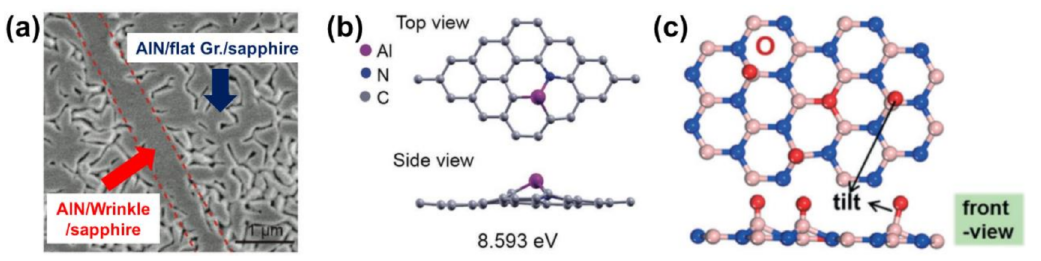
Figure 21. ( a ) SEM image of AlN grown on graphene wrinkle arrays. Due to the increased nucleation sites caused by graphene wrinkles, AlN grown on the wrinkles (red region) demonstrates faster lateral coalescence. Reprinted from [97] with copyright permission. ( b ) Schematic diagrams of atom connective structure of graphene after N 2 plasma treatment. The purple, blue, and gray solid balls represent Al, N, and C atoms, respectively. Reprinted from [96] with copyright permission. ( c ) Schematic diagrams of atom connective structure of h-BN after O 2 plasma treatment. The pink, blue, and red solid balls represent B, N, and O atoms, respectively. Reprinted from [95] with copyright